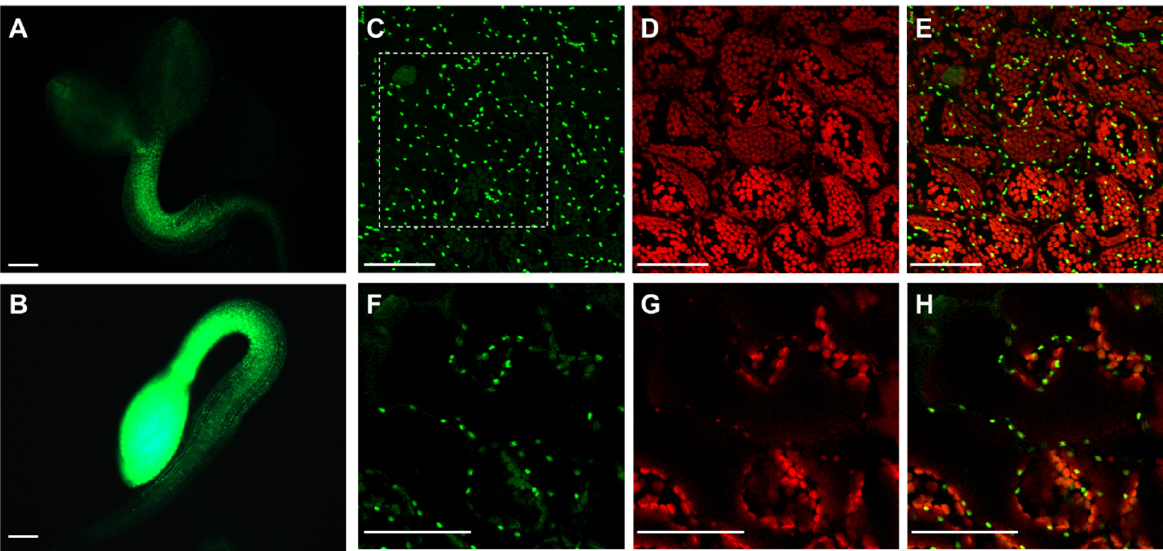
Figure 5. Light reduces APx-R-YFP signal in APx-R-YFP OE seedlings. Fluorescence microscopy analysis of two-day-old plants from AtAPx-R-YFP OE-1 line germinated in the light ( A ) or dark ( B ). ( C – E ) Confocal laser scanning microscope z-stack images from residual fluorescence localized on cotyledons of a plant germinated in the light under a 60× objective. ( F – H ). Zoom-in cross-section image from the dashed square indicated on ( C ). YFP fluorescence is shown in green ( A – C , F ) and chlorophyll autofluorescence ( D , E , G , H ), in red. Scale ( A , B ) 200 µm; and ( C – H ) 50 µm.